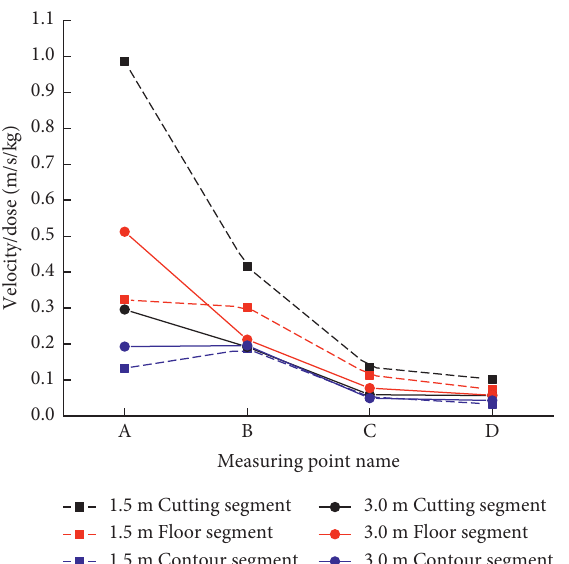
Figure 11: Comparison of the ratios of the vibration velocity to a single-segment explosive charge of the typical blasting segments with different footage conditions at the monitoring points A, B, C, and